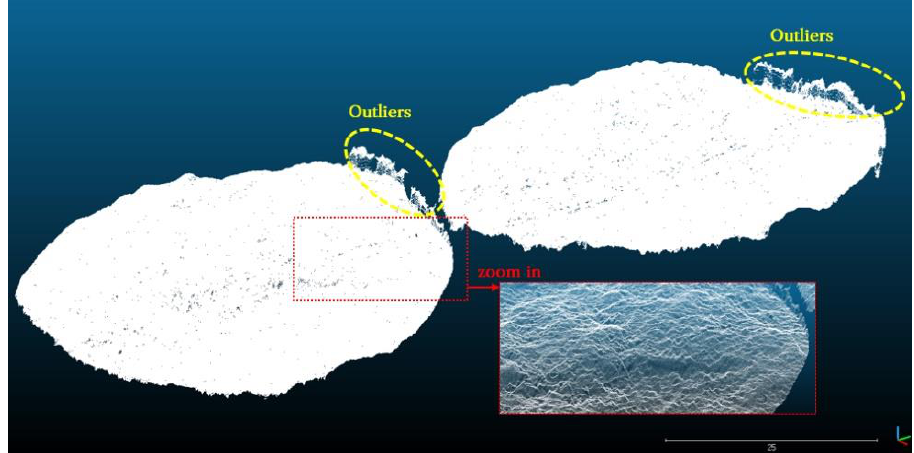
Figure 1. Example of point cloud data of fracture surfaces acquired using a laser scanning